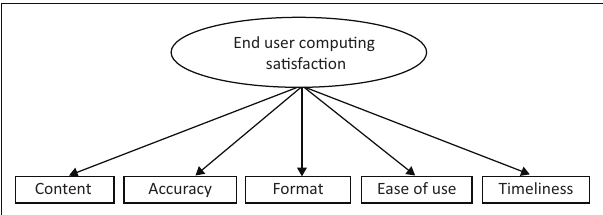
FIGURE 1: Description of implementation of Government Electronic Payment Gateway system. FIGURE 2: The end-user satisfaction model of information